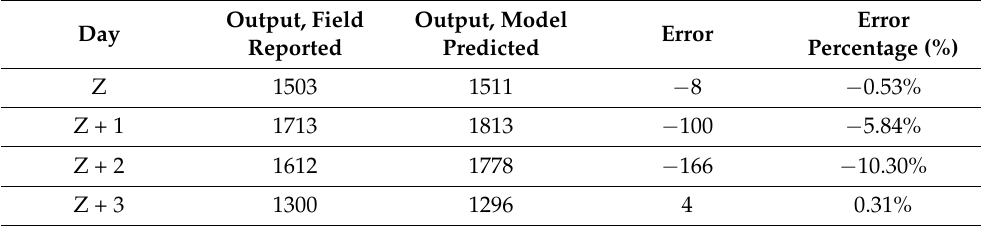
Table 7. The prediction accuracy of the gnLSTM model with 15 min data training on day